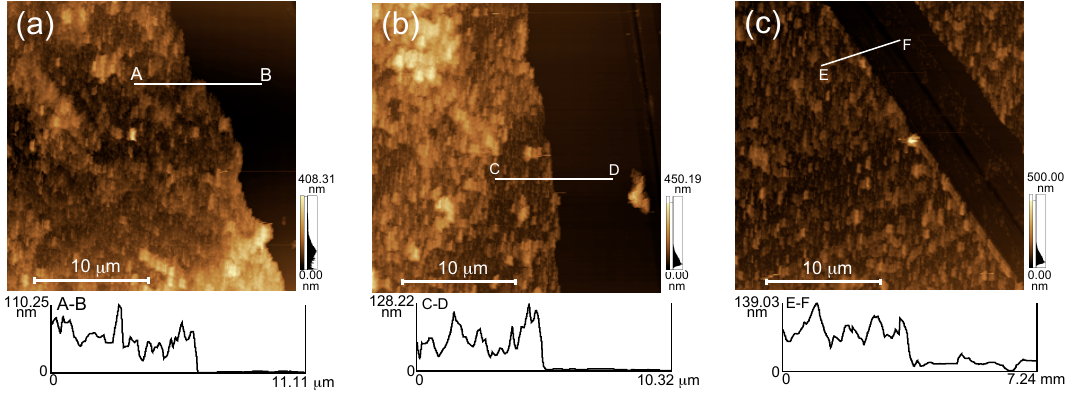
Figure 3. Atomic force microscopy (AFM) images of the ( a ) (NAF/PAH) 5 NAF; ( b ) (NAF/PEI) 5 NAF; and ( c ) (NAF/PDDA) 5 NAF films.